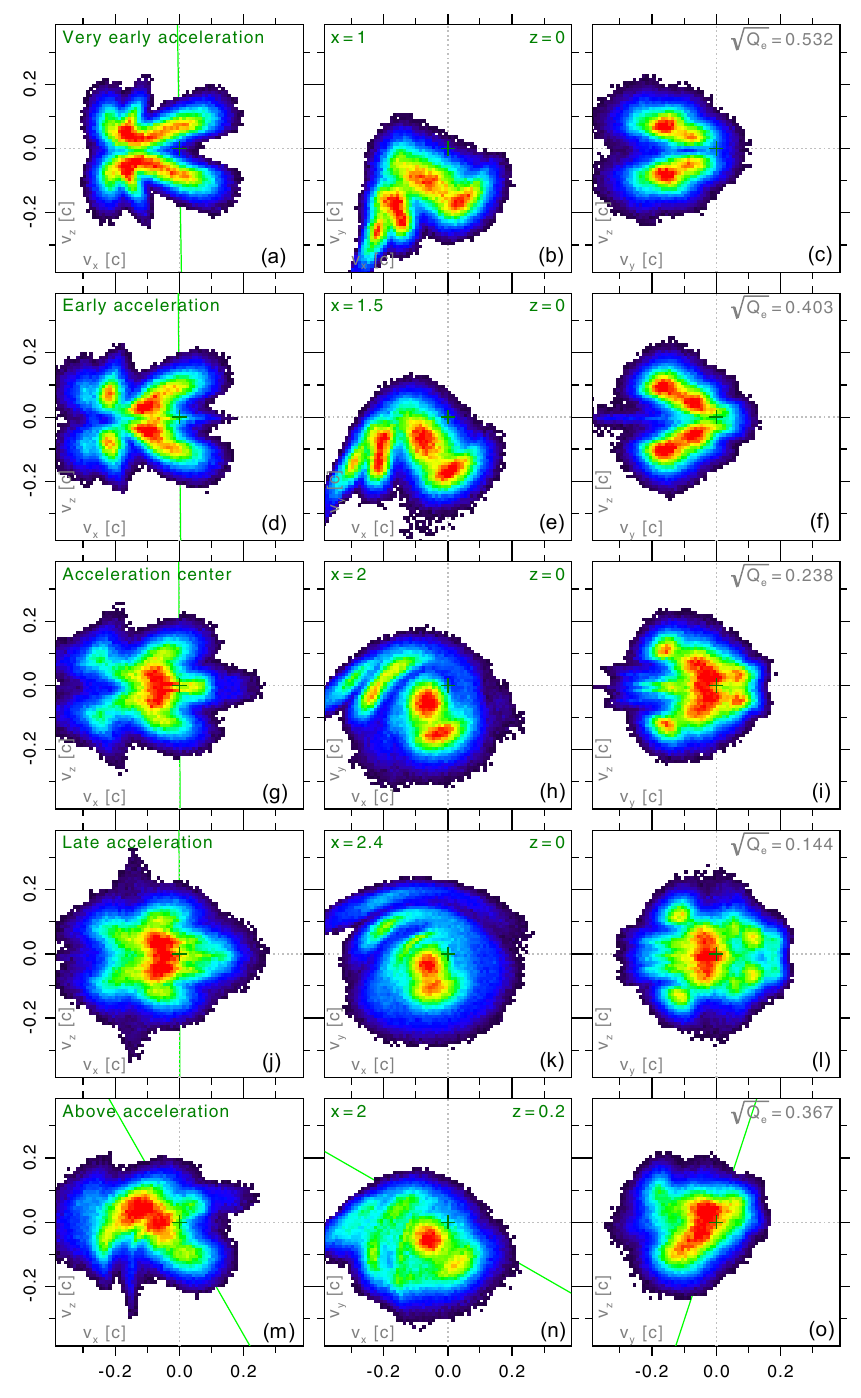
Figure 7. Same as Fig. 5 but for the acceleration